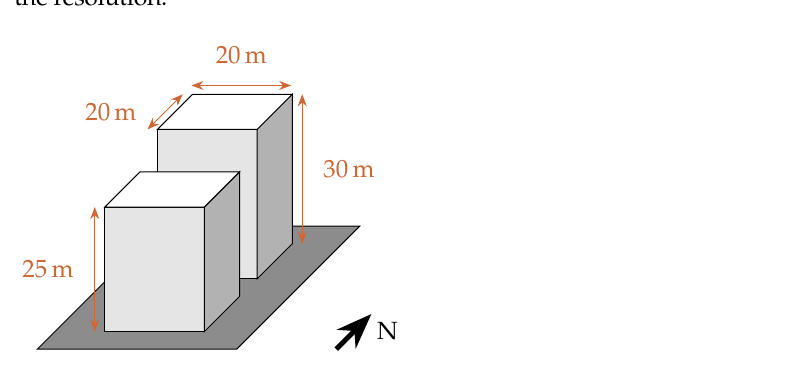
Figure 5. Geometry used for the study of the influence of the